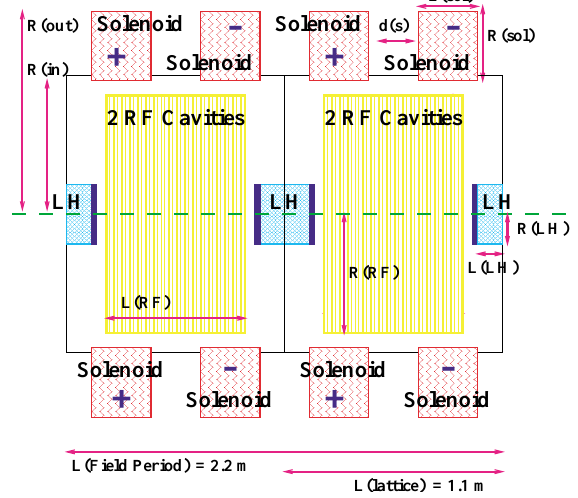
FIG. 5. (Color) FOFO cooling cell